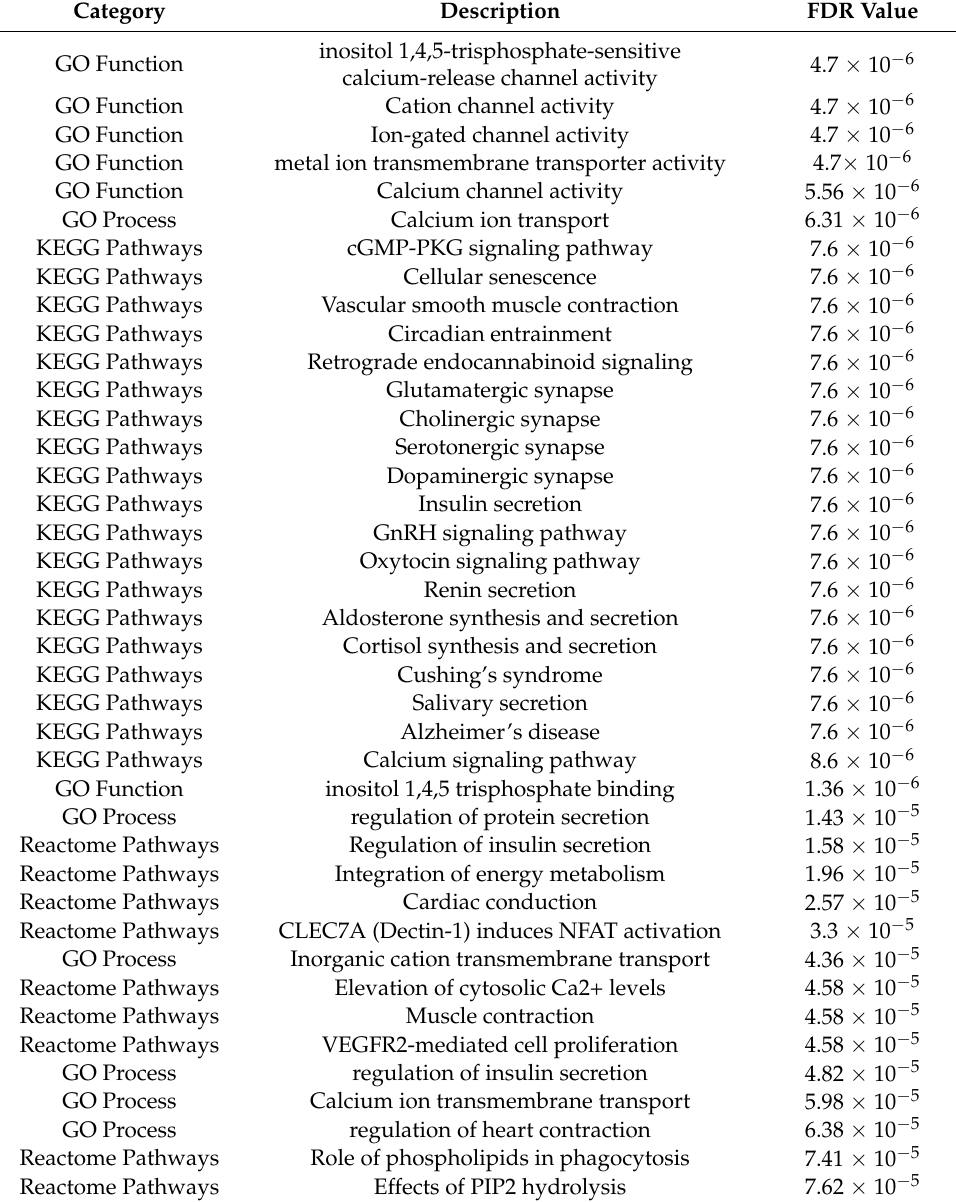
Table 3. Functional enrichment of the first subcluster of the protein–protein interaction (PPI) network.